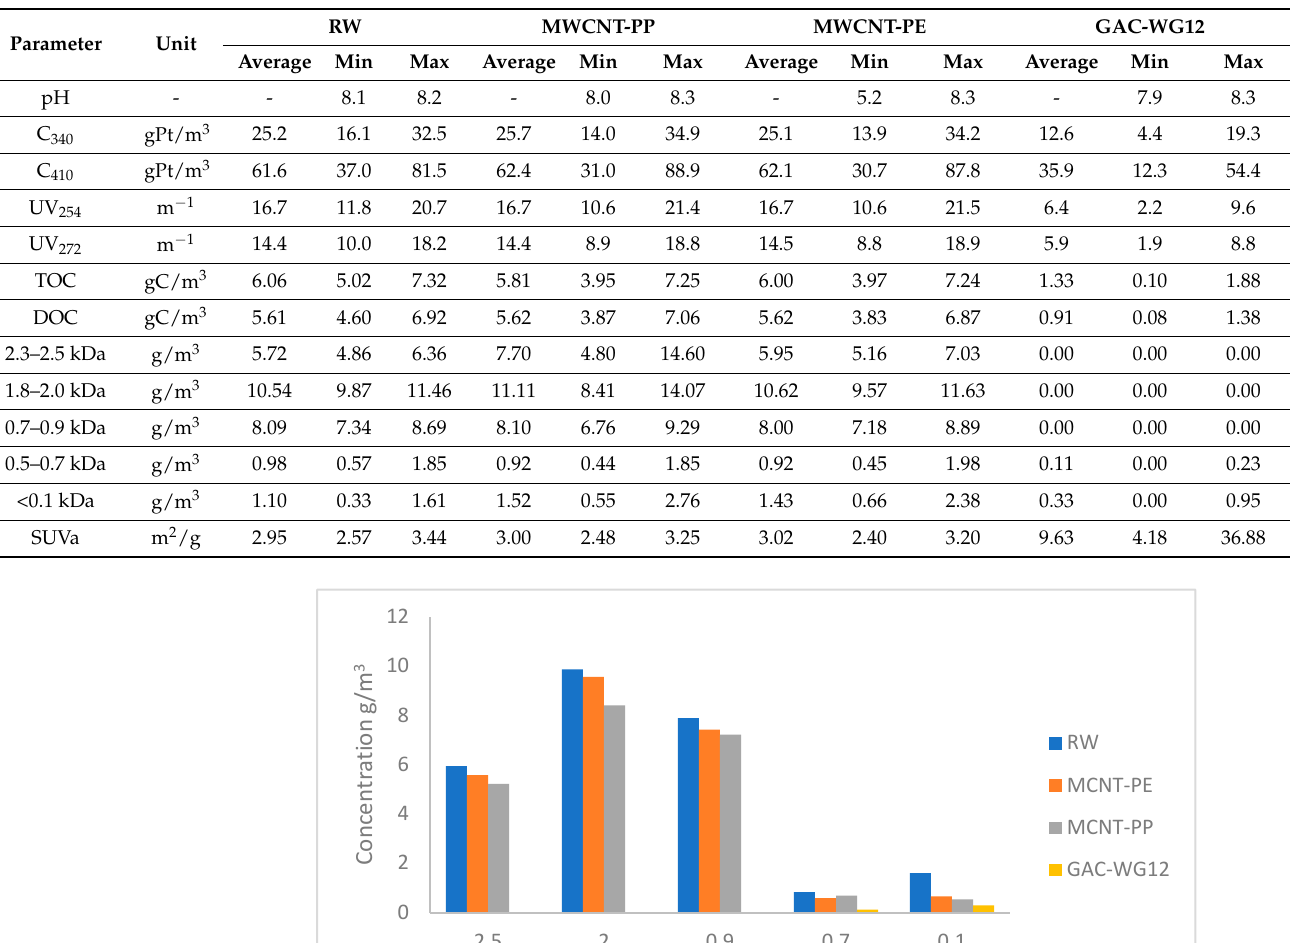
Table 1. Ranges of water quality parameters before and after adsorption.